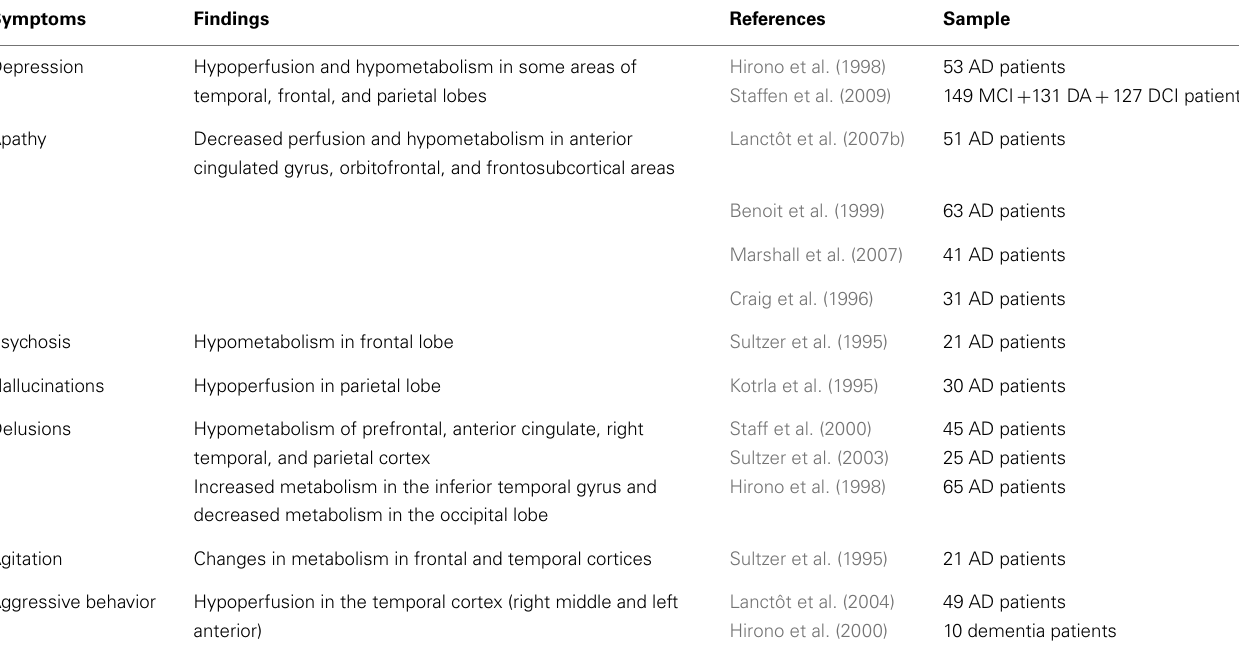
Table 7 | BPSD and functional changes in neuroimaging exams (PET and SPECT